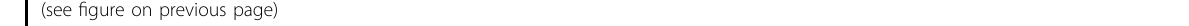
Fig. 4 Nuclear PD-L1 facilitates angiogenesis through EGR1. a HUVEC migration assay that investigates the effect of EGR1 re-expression in PD-L1- silenced cells on the migration ability of HUVECs. Scale bars, 100 µm. b Statistical analysis of the HUVEC migration assay. n = 3. Data are presented as means ± SD. Two-tailed unpaired Student ’ s t -test. c HUVEC tube formation assay that investigates the effect of EGR1 re-expression in PD-L1-silenced cells on HUVEC tubule formation. Scale bars, 25 µm. d Statistical analysis of the HUVEC tube formation assay. n = 3. Data are presented as means ± SD. Two-tailed unpaired Student ’ s t -test. e CAM assay that investigates the effect of EGR1 re-expression in PD-L1-silenced cells on the blood vessel density of CAM. f Statistical analysis of the CAM assay. n = 5. Data are presented as means ± SD. Two-tailed unpaired Student ’ s t -test. g Representative bioluminescent images of UM orthotopic xenografts generated by PD-L1-silenced cells that re-express EGR1. h Statistical analysis of the bioluminescent signals in UM orthotopic xenografts. n = 5. Data are presented as means ± SD. Two-tailed unpaired Student ’ s t -test. i Statistical analysis of the tumor weight. n = 5. Data are presented as means ± SD. Two-tailed unpaired Student ’ s t -test. j Representative images of H&E staining of UM orthotopic xenografts generated by PD-L1-silenced cells that re-express EGR1. k IF images of CD31 in UM orthotopic xenografts constructed by EGR1 re-expression in PD-L1-silenced cells. Scale bars, 40 µm. l Statistical analysis of CD31 expression in UM orthotopic xenografts. n = 5. Data are presented as means ± SD. Two-tailed unpaired Student ’ s t -test. m – o Gene expression correlation analysis of PD-L1 and EGR1 ( m ), PD-L1 and VEGFA ( n ), EGR1 and VEGFA ( o ) in UM patients using TCGA database. p , q Kaplan – Meier analysis of the overall survival of UM patients with low and high EGR1 ( p ) and VEGFA ( q ) expression levels using TCGA database. r Schematic diagram showing that nPD-L1 facilitates angiogenesis in UM through transcriptional activation of EGR1